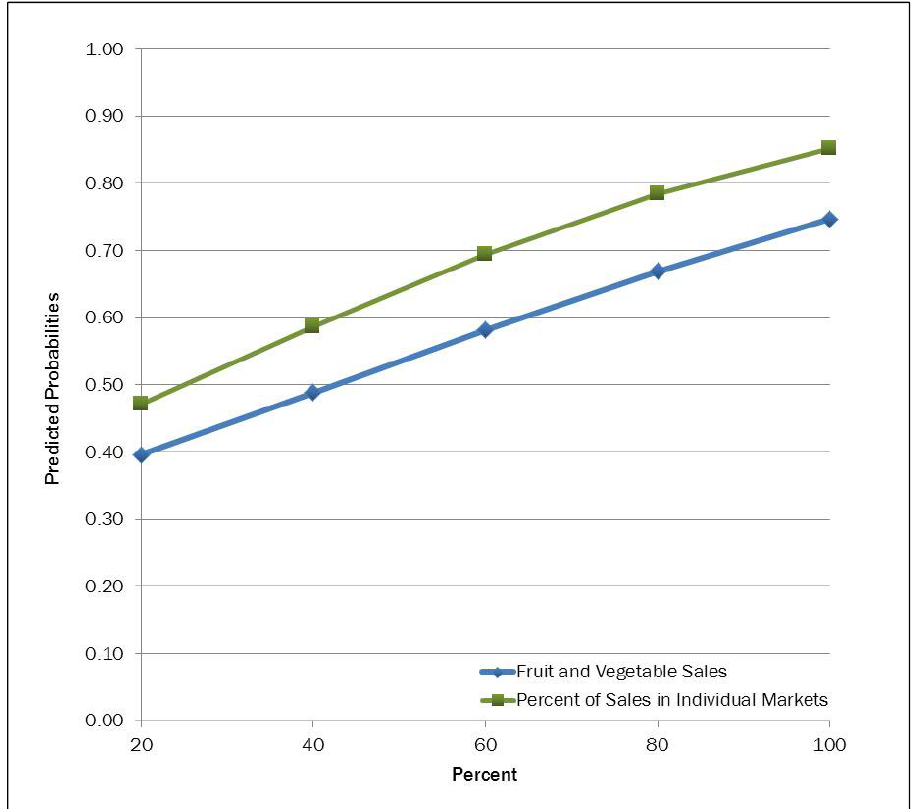
Figure 1. Predicted Probabilities: Fruit and Vegetable Sales and Dependence on